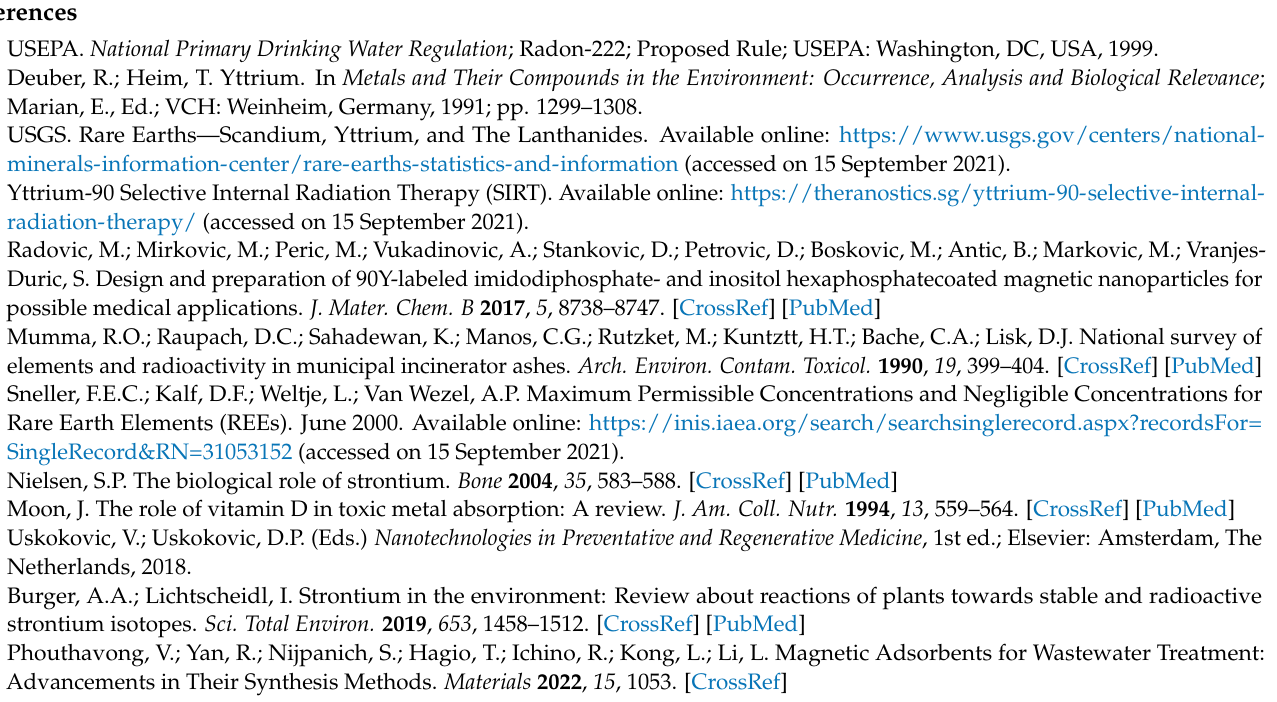
ticles; Figure S4. Retention percentage of Sr(II) by Phy@Fe 3 O 4 NPs versus the initial concentration of Sr(II); Figure S5. Sr(II) retention percentage with different amounts of Phy@Fe 3 O 4 NPs; Figure S6. UO 22+ retention percentage with different amounts of Phy@Fe 3 O 4